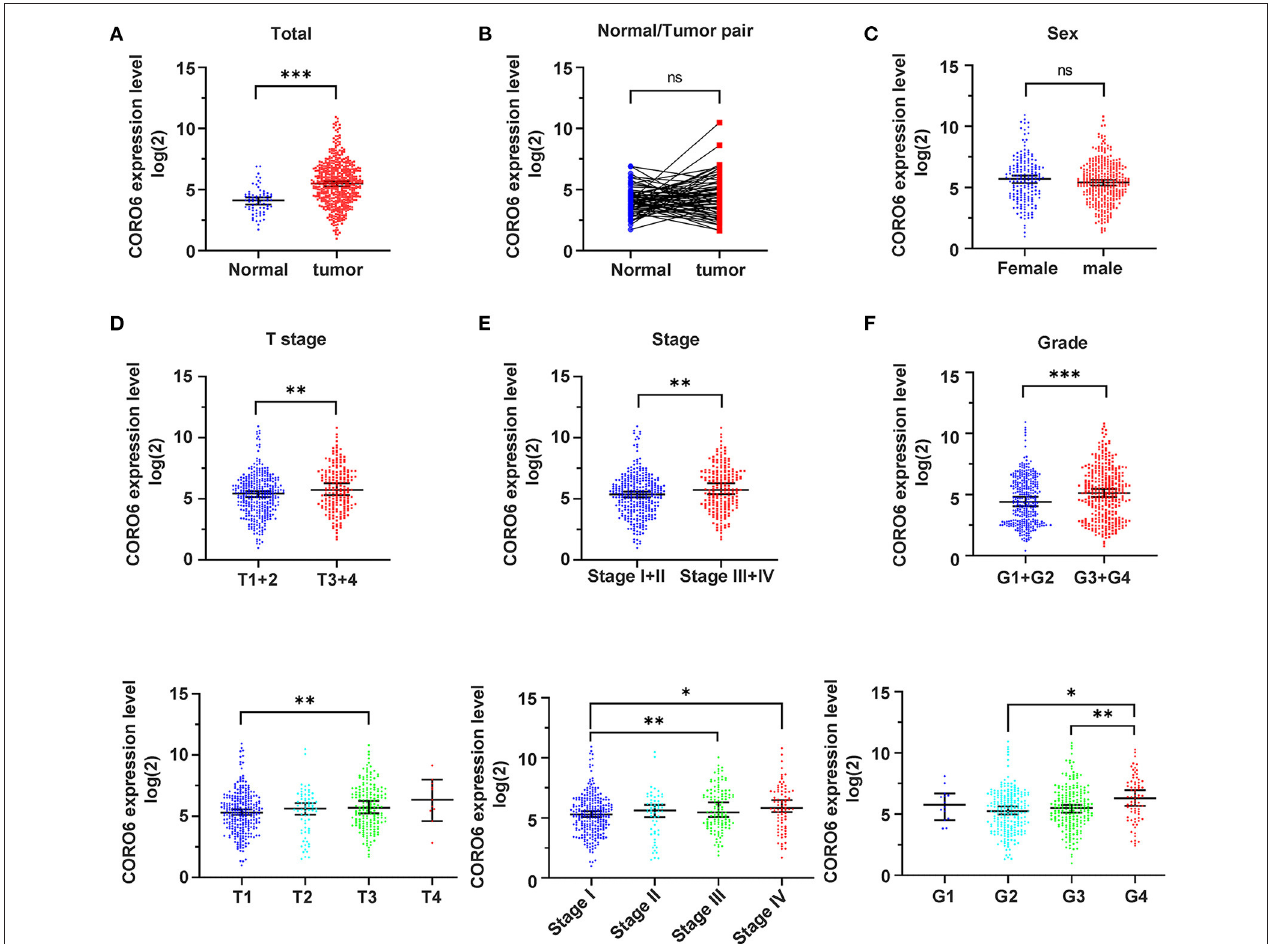
FIGURE 1 | CORO6 upregulation in ccRCC patients. (A) The CORO6 mRNA level was significantly increased in ccRCC patients ( n = 533) compared to normal kidney tissues ( n = 72). (B) The CORO6 mRNA level was indistinguishable between ccRCC ( n = 72) and paired adjacent tissues ( n = 72). (C) The CORO6 expression level displayed no correlation with sex hormones. (D) Top: the CORO6 mRNA level was upregulated in ccRCC patients with T stage III + IV compared to patients with T stage I + II. Bottom: ccRCC patients with T stage III tended to express a higher level of CORO6 compared to patients with T stage I. (E) Top: the CORO6 mRNA level was elevated in ccRCC patients with TNM stage III + IV compared to patients with TNM stage I + II. Bottom: ccRCC patients with TNM stage III or IV tended to express a higher level of CORO6 when compared to patients with TNM stage I. (F) Top: the CORO6 mRNA level was upregulated in ccRCC patients with G3 + G4 compared to patients with G1 + G2. Bottom: ccRCC patients with G4 tended to express a higher level of CORO6 compared to G2 + G3. One way ANOVA test was performed in bottom panels of (D–F) . * P < 0.05, ** P < 0.01, and *** P < 0.001. Ns, no significance.